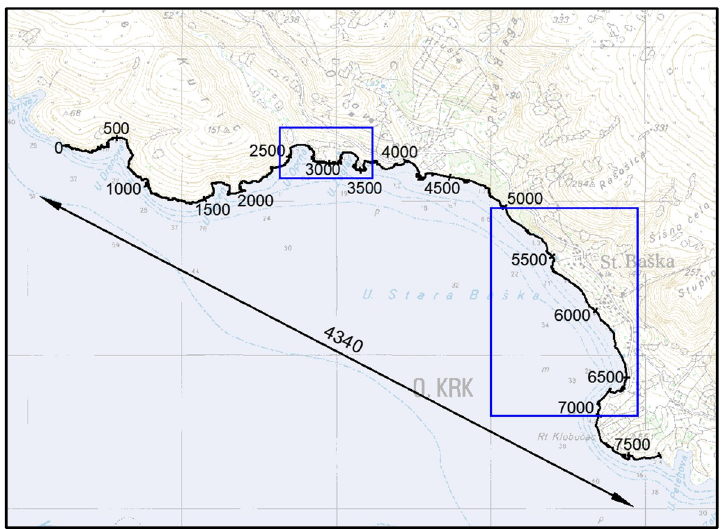
Figure 4. Investigated coastline stations: 0–7720 m, used for the Coastal Vulnerability Index (CVI) analysis. Blue rectangles show areas discussed in more detail.